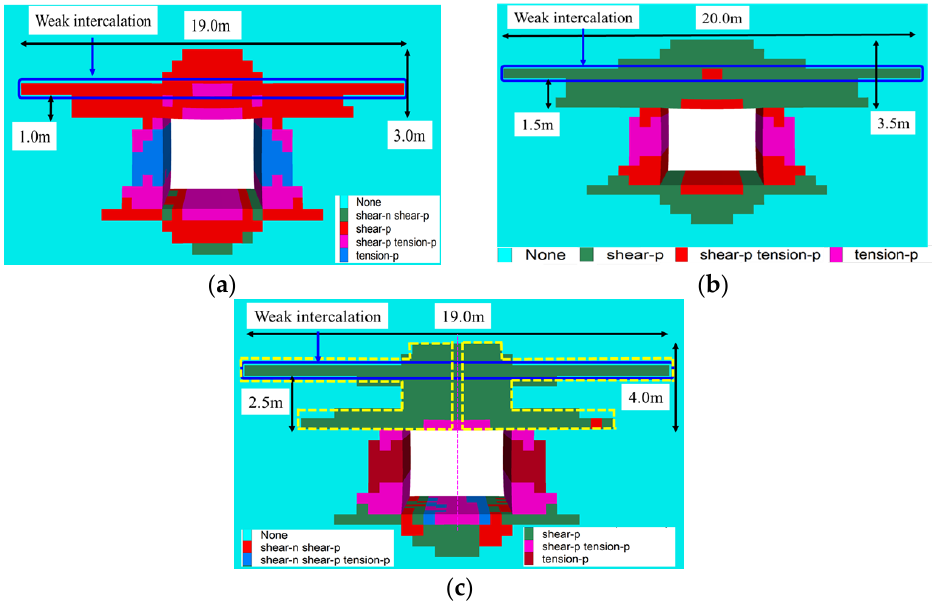
Figure 11. Simulation Results of Scheme VII. ( a ) Scheme VII — 0.5 times L . ( b ) Scheme VII — 0.8 times L . ( c ) Scheme VII — 1.0 times L .